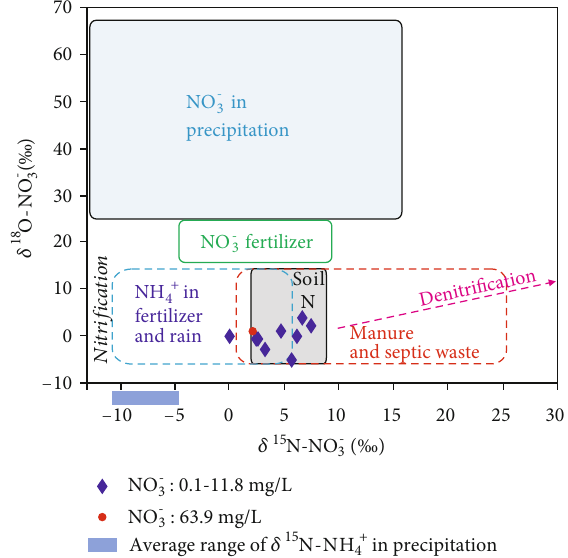
Figure 6: The relationship between δ 15 N-NO 3- and δ 18 O-NO 3- for spring water. The range for δ 15 N-NO 3- and δ 18 O-NO 3- and average range for δ 15 N-NH 4+ for precipitation is from Guiyang and Chongqing. The schematic of typical ranges for other sources is from [44,